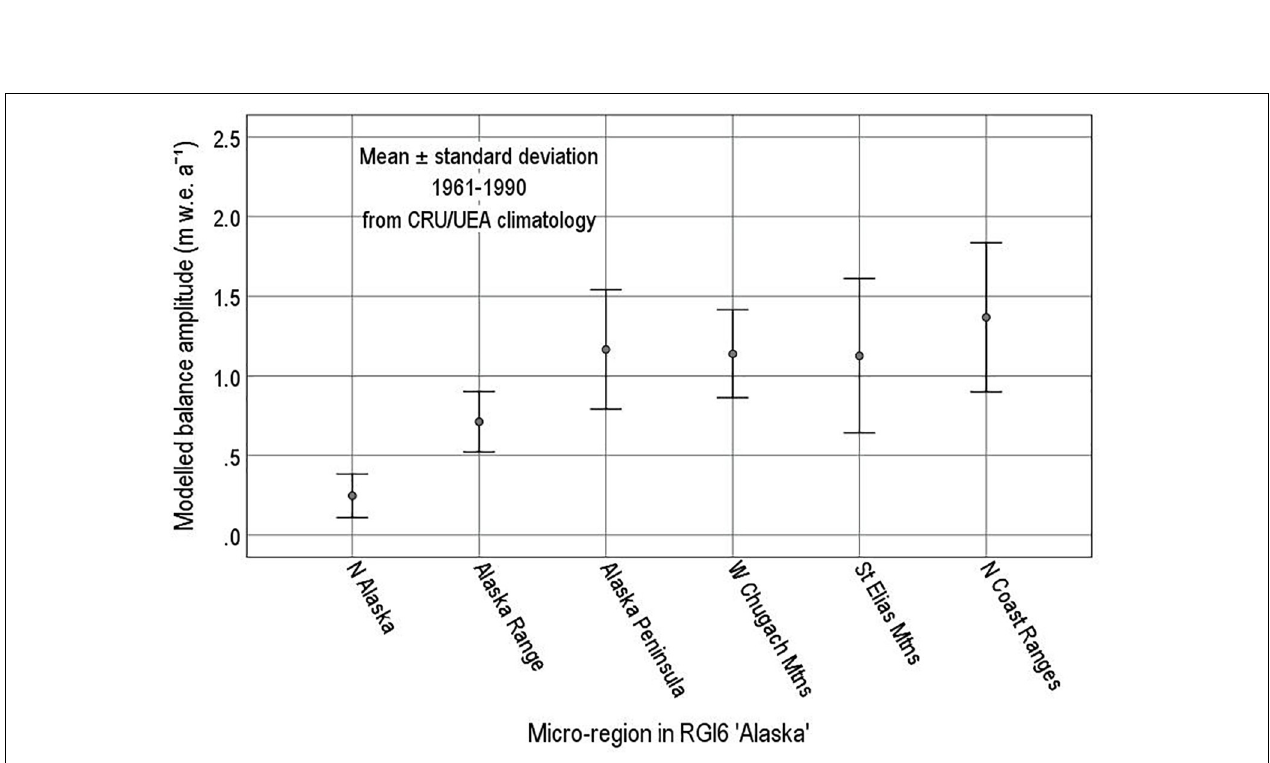
FIGURE 11 | Modelled balance amplitude for six micro-regions in the Randolph Glacier Inventory (RGI Consortium, 2017) for macro-region “Alaska.”